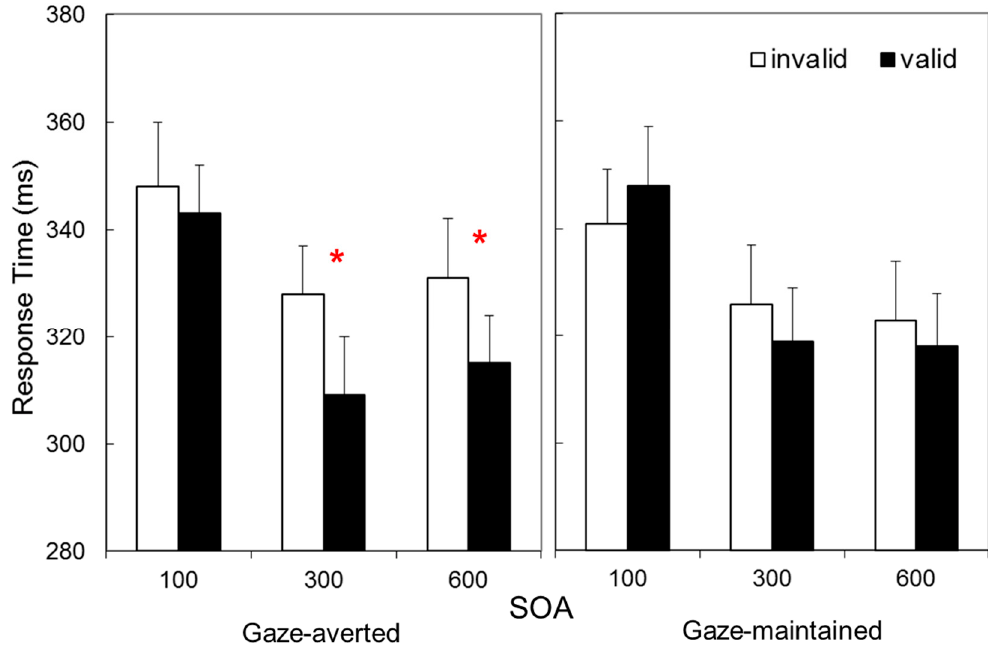
Figure 2. Data from Experiment 1. Response times in a Posner task as a function of whether an avatar cue was gaze-averted or gaze-maintained, and whether it was a valid or invalid predictor of a target at three cue-target onset asynchronies. * indicates statistically significant simple effect, p < .001.